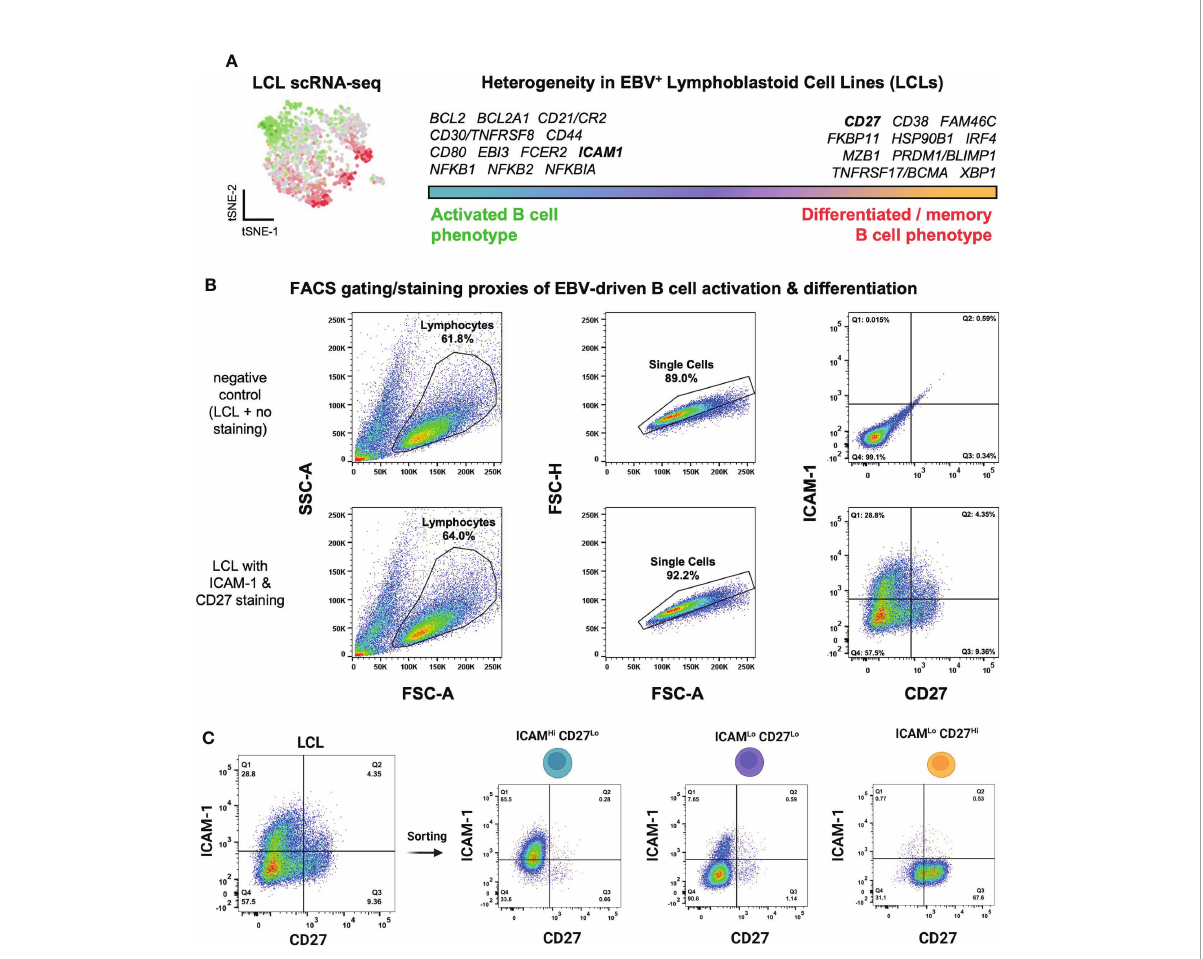
FIGURE 1 Isolation of EBV + activated and differentiated B cell phenotypes identi fi ed from lymphoblastoid cell line scRNA-seq. (A) Top differentially expressed genes between activated and differentiated B cells from representative LCL scRNA-seq data from prior work (111). (B) Flow cytometry gating strategy to assess LCL heterogeneity through proxy surface marker expression. (C) Sorting of three ICAM/CD27 phenotypes from LCLs. ICAM-1 Hi /CD27 Lo = activated B cells; ICAM-1 Lo /CD27 Lo = intermediate states; ICAM-1 Lo /CD27 Hi = differentiated B